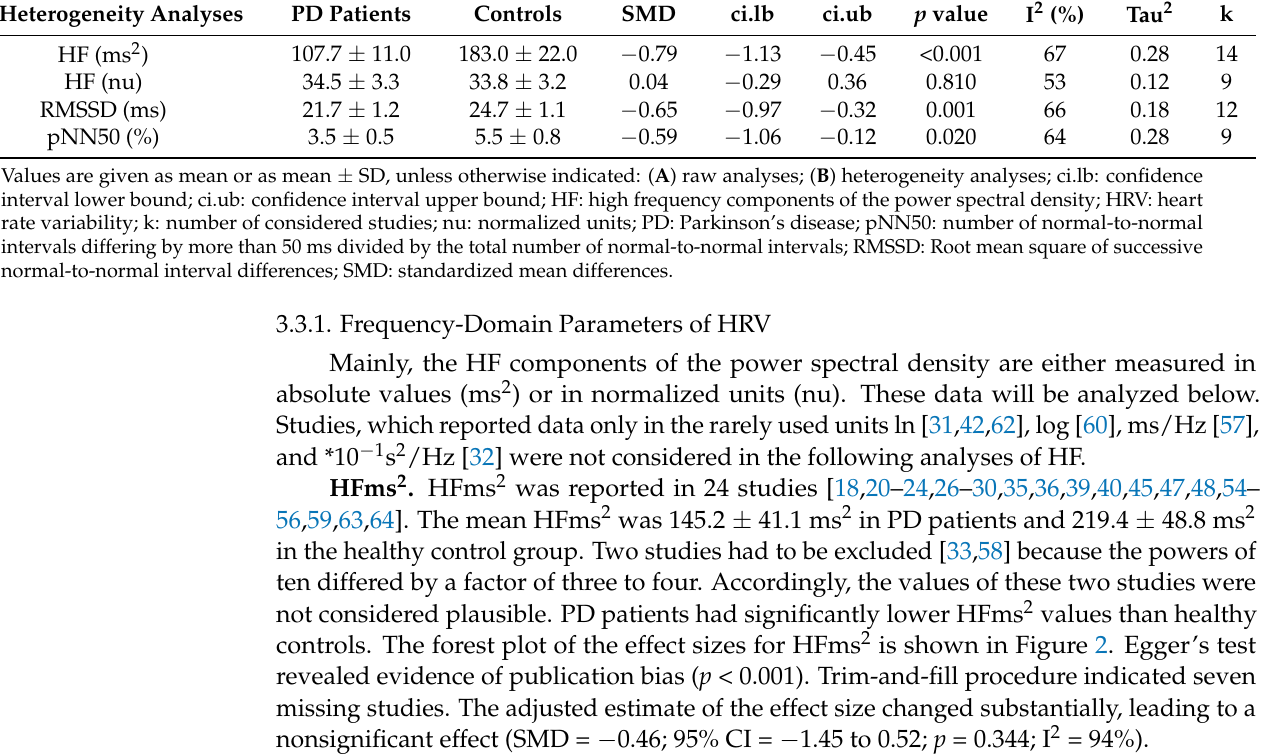
(B) Heterogeneity Analyses PD Patients